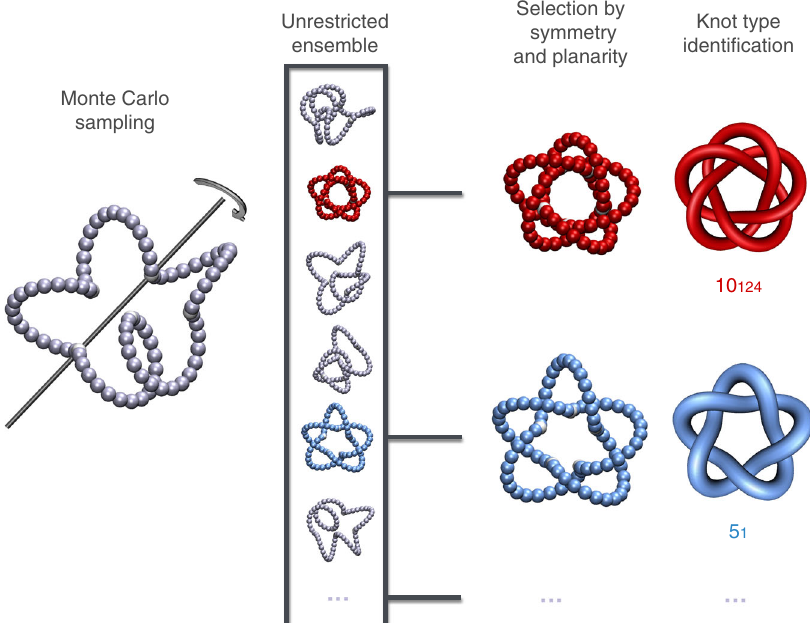
Fig. 1 Discovery of privileged topologies. The two-tier strategy to detect admissible topologies consists of an initial Monte Carlo sampling of closed constructs made of n T = 3, 4, 5 helical templates followed by an a posteriori selection of the quasi-planar, cyclic-symmetric and knotted instances. In this n T = 5 example, the ensemble generated with unrestricted crankshaft moves includes two such instances: the 10 and in other fi gures the attractive patches joining the helical templates (discretised as chains of beads) are shown as white beads larger than their actual